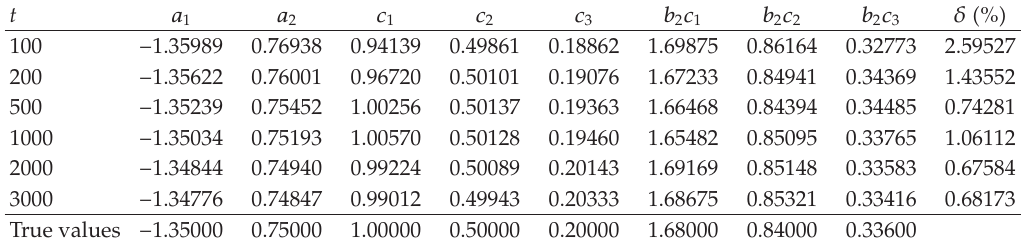
Table 1: The parameter estimates (cid:2) θ (cid:3) (cid:2) σ 2 (cid:7) 0 . 50 2 , δ ns (cid:7) 10 . 96% (cid:3) .